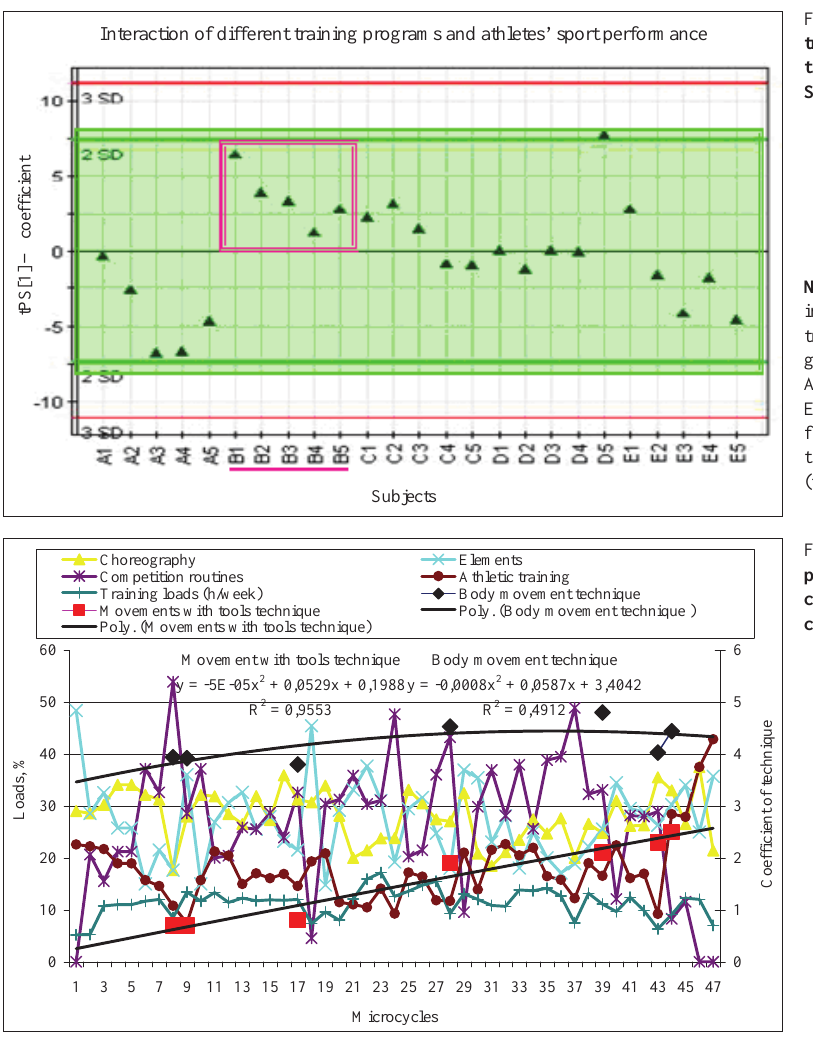
Figure 1. Comparisons of training and fi - tness models (diagrammatical representa- tion of model data was performed using SIMCA-P program)